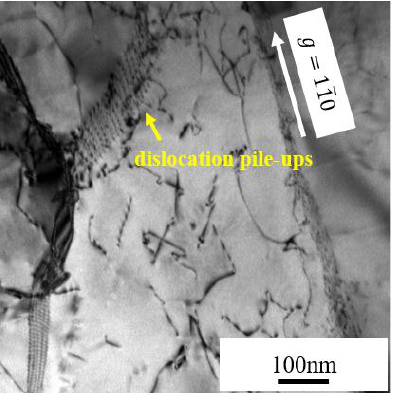
Figure 9. Dislocation pile-ups at a subgrain boundary in the Fe-9Cr alloy irradiated at 550°C.